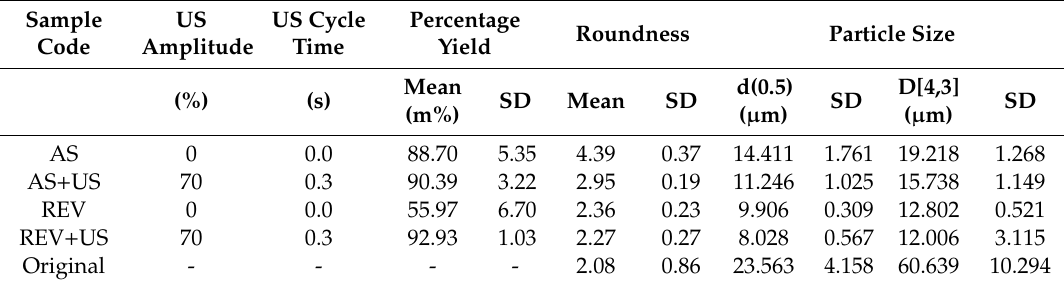
Table 1. Crystallization results of conventional crystallization